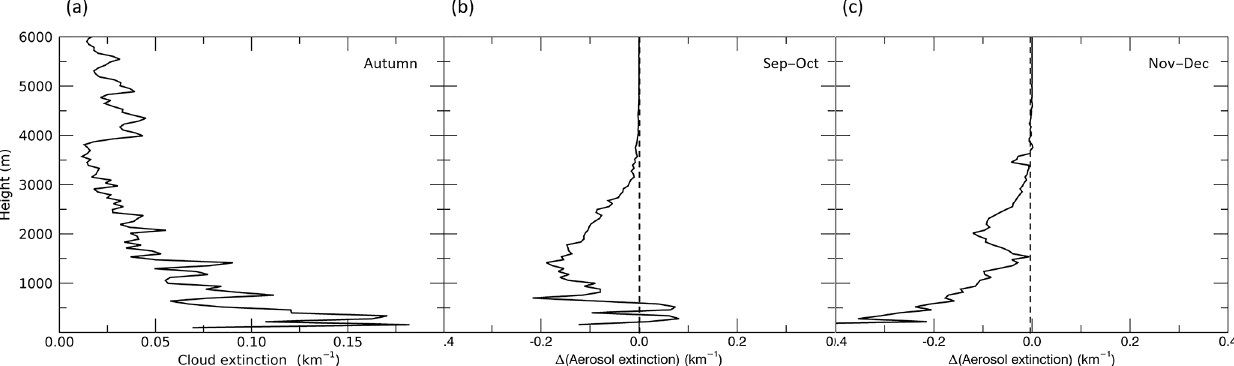
Figure 11. Profiles of cloud and aerosol changes over southern China. (a) Cloud extinction in autumn (September–November), estimated based on LIVAS CALIPSO data from 2007 to 2011. Aerosol extinction change for September–October (b) and November–December (c) based on CALIPSO level 3 data from 2007 to